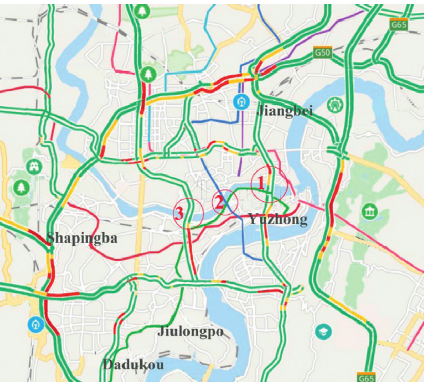
Figure 5: Locations of bridges in maintaining: locations of bridges Huanghuayuan in position 1, Yuao in position 2, and Jiahua in position